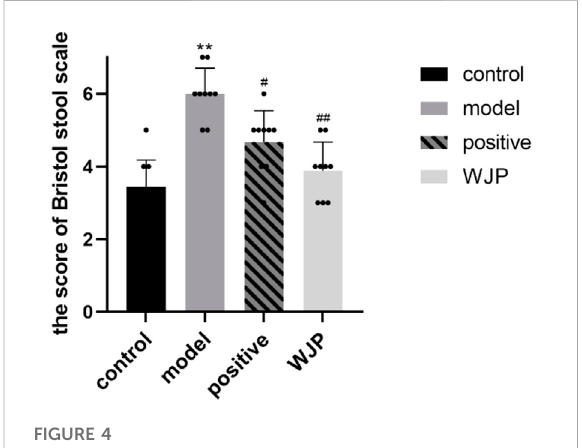
FIGURE 4 Comparison of Bristol stool scale score.